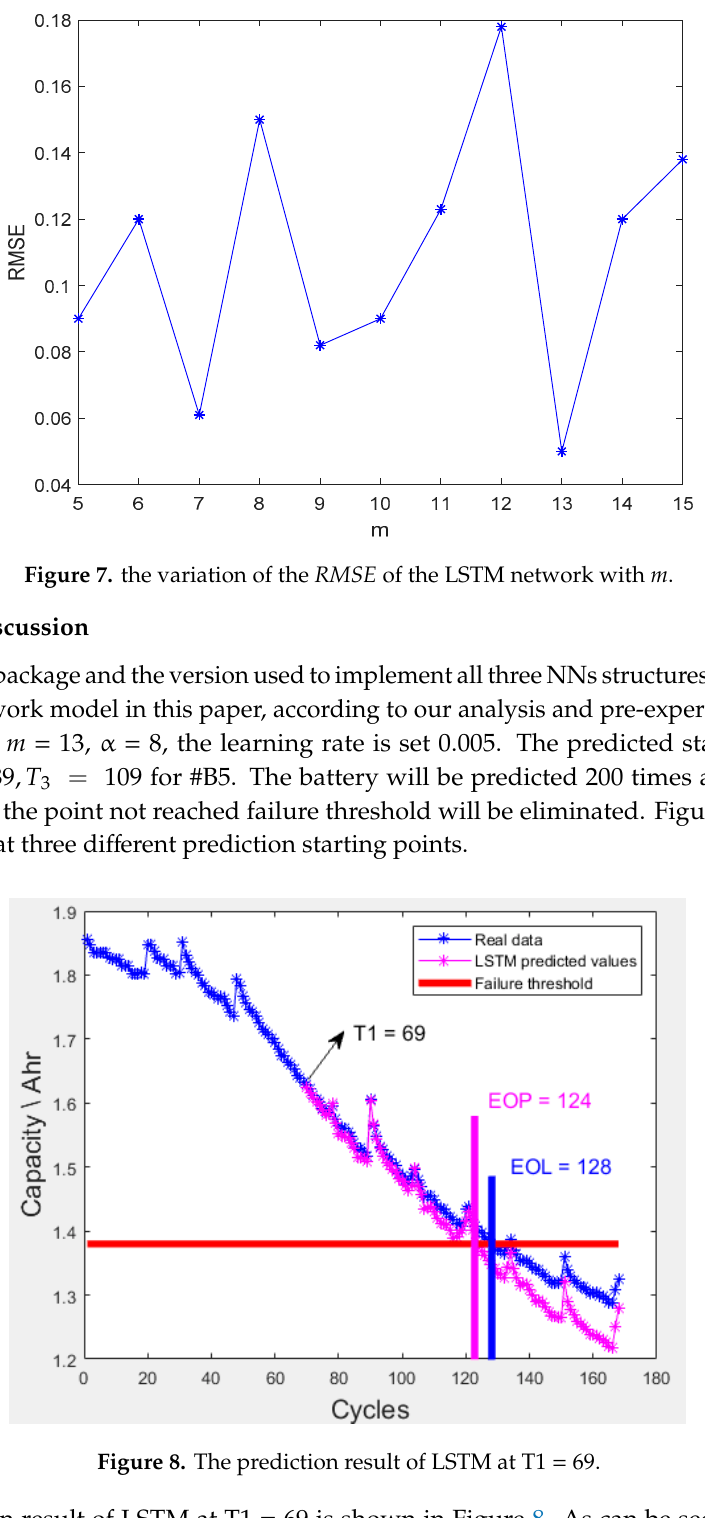
Figure 9. The prediction result of LSTM at T2 = 89. The prediction result of LSTM at T2 = 89 is shown in Figure 9. As can be seen in Figure 9, now the prediction result is 130 and the relative error is 2, which means that the prediction error is gradually decreasing.